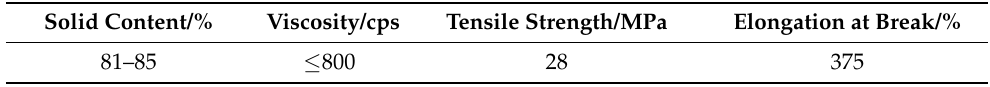
Figure 2. Particle size distribution of the SPUA modifier. 2.2. Test Method The main research routes are shown in Figure 3. First, the optimum shearing time, rate and temperature of the SPMA were determined by an orthogonal test. On this basis, the high ‐ temperature performance and fatigue performance of SPMA with different con ‐ tents were studied. Among them, the high ‐ temperature performance included the RV test, PG test and MSCR test. The fatigue performance tests included the LAS test and the TS test. Finally, applicability of various performance indexes to the SPMA was evaluated.